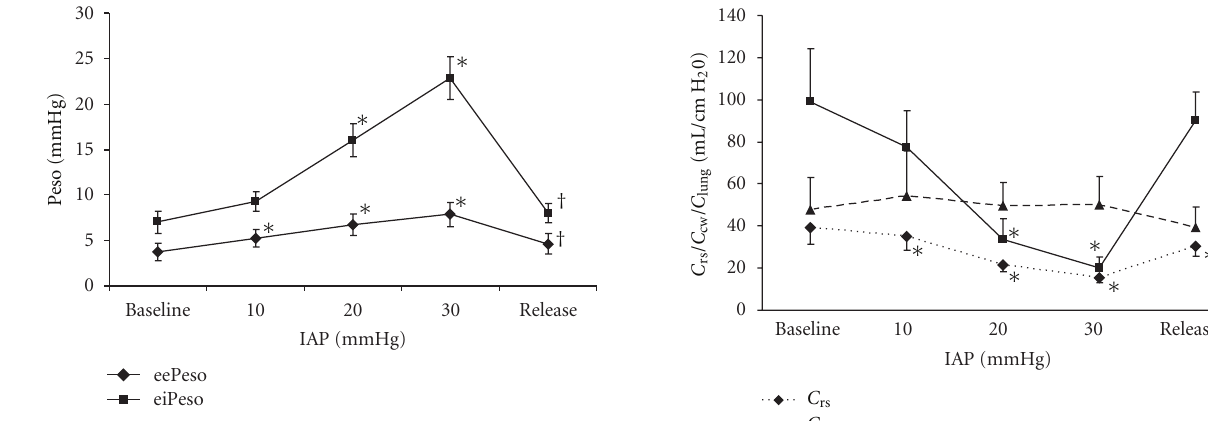
Figure 1: E ff ect of increasing intra-abdominal pressure (IAP) on end-expiratory esophageal pressure (eePeso) and end-inspiratory esophageal pressure (eiPeso). Baseline = 6mmHg, release = 5mmHg. Data are expressed as mean ± SEM. ∗ P = 0 . 04 versus baseline, † P = 0 . 04 versus IAP = 30.